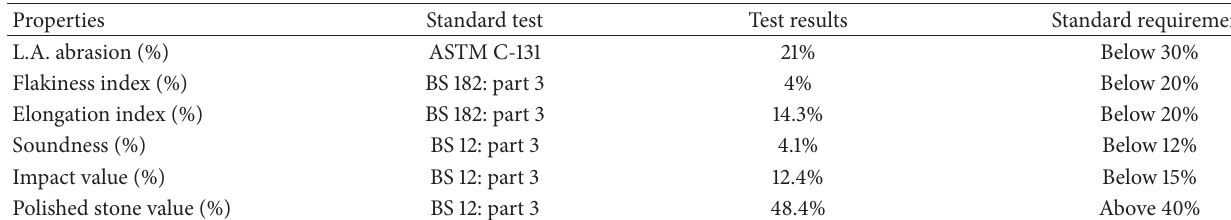
Table 4: Properties of coarse and fine aggregate.